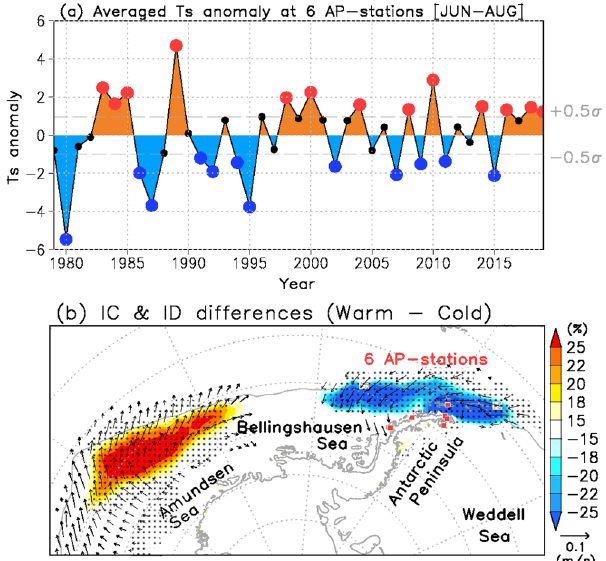
Fig. 1 Surface anomalies of West Antarctica. a Time series of averaged surface air temperature anomalies (°C, deviation from climatology for 1979 – 2019) during June to August at six Antarctic Peninsula stations (Bellingshausen, O ’ Higgins, Esperanza, Marambio, Vernadsky and Rothera). Red and blue dots indicate the top thirteen warm winters and twelve cold winters. Dashed lines show one-half standard deviation (±0.5 σ ). b Difference map of sea ice concentration (IC) (%: shaded) and ice drifting speed (ID) (m/s: vector) between warm and cold winters. Dotted areas denote signi fi cant differences exceeding the 95% con fi dence